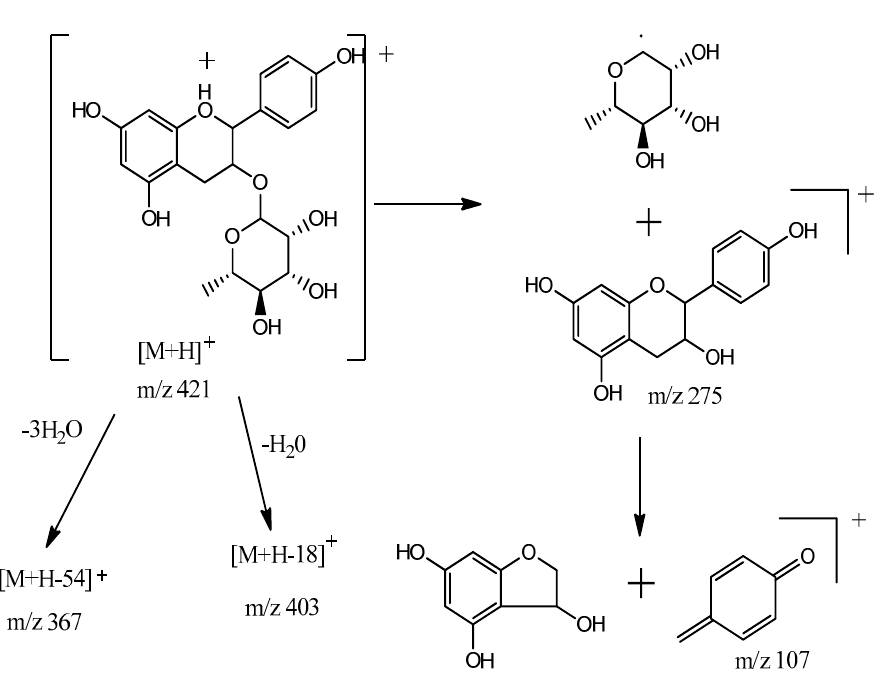
Figure 7. Fragmentation pattern of afzelechin 3- O -alpha- L -rhamnopyranoside.